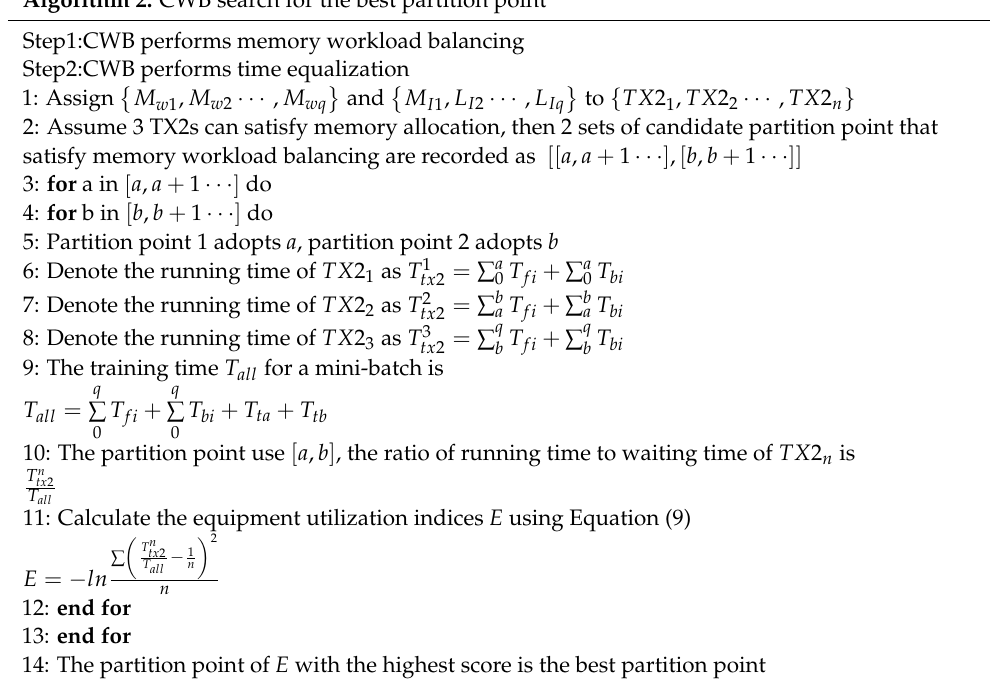
Algorithm 2. CWB search for the best partition